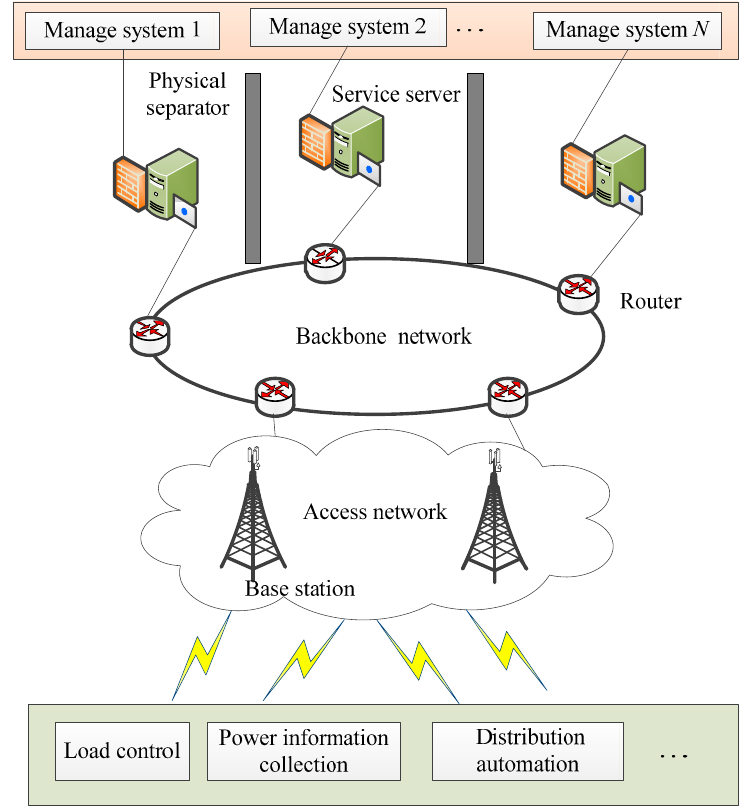
Figure 1. Illustration of the power wireless private network architecture.